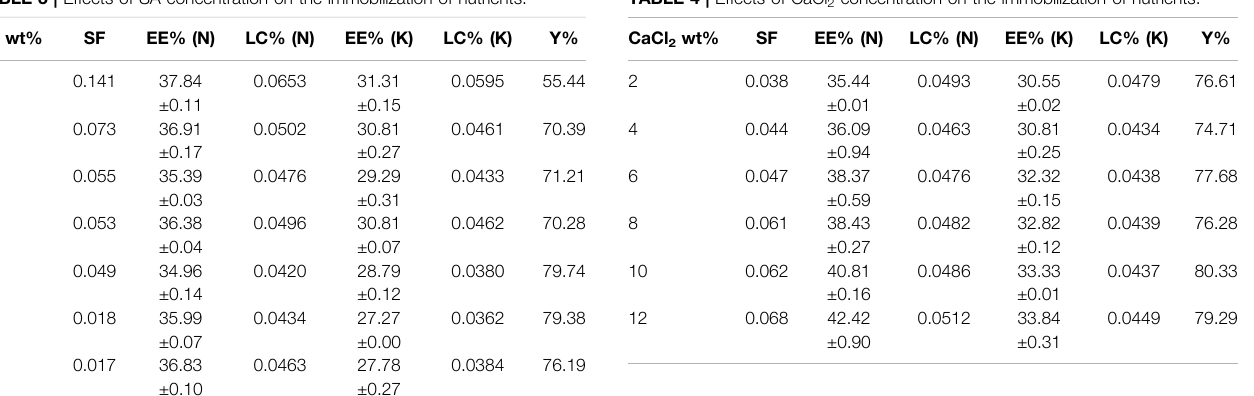
TABLE 3 | Effects of SA concentration on the immobilization of nutrients. TABLE 4 | Effects of CaCl 2 concentration on the immobilization of nutrients.